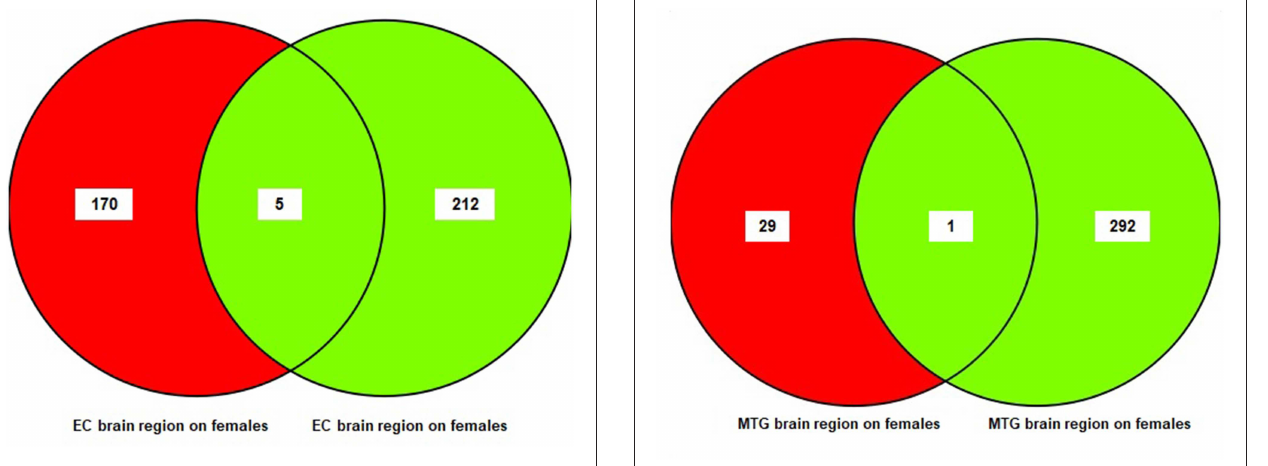
FIGURE 4 | The number of common genes obtained from medial temporal gyrus (MTG) in females and males visualized by a Venn